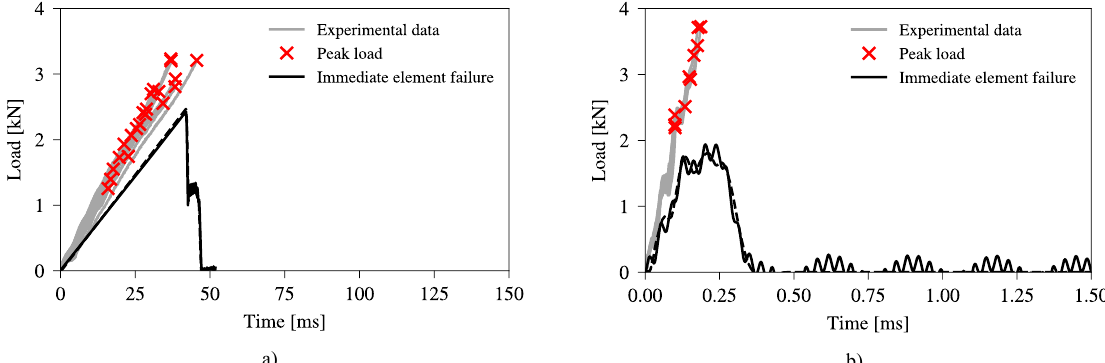
Fig. 12 Simulation results for the immediate element failure model compared to experimental data for target piston velocities of a) 10 mm/s and b) 1000 mm/s. (― load ring; - - - support